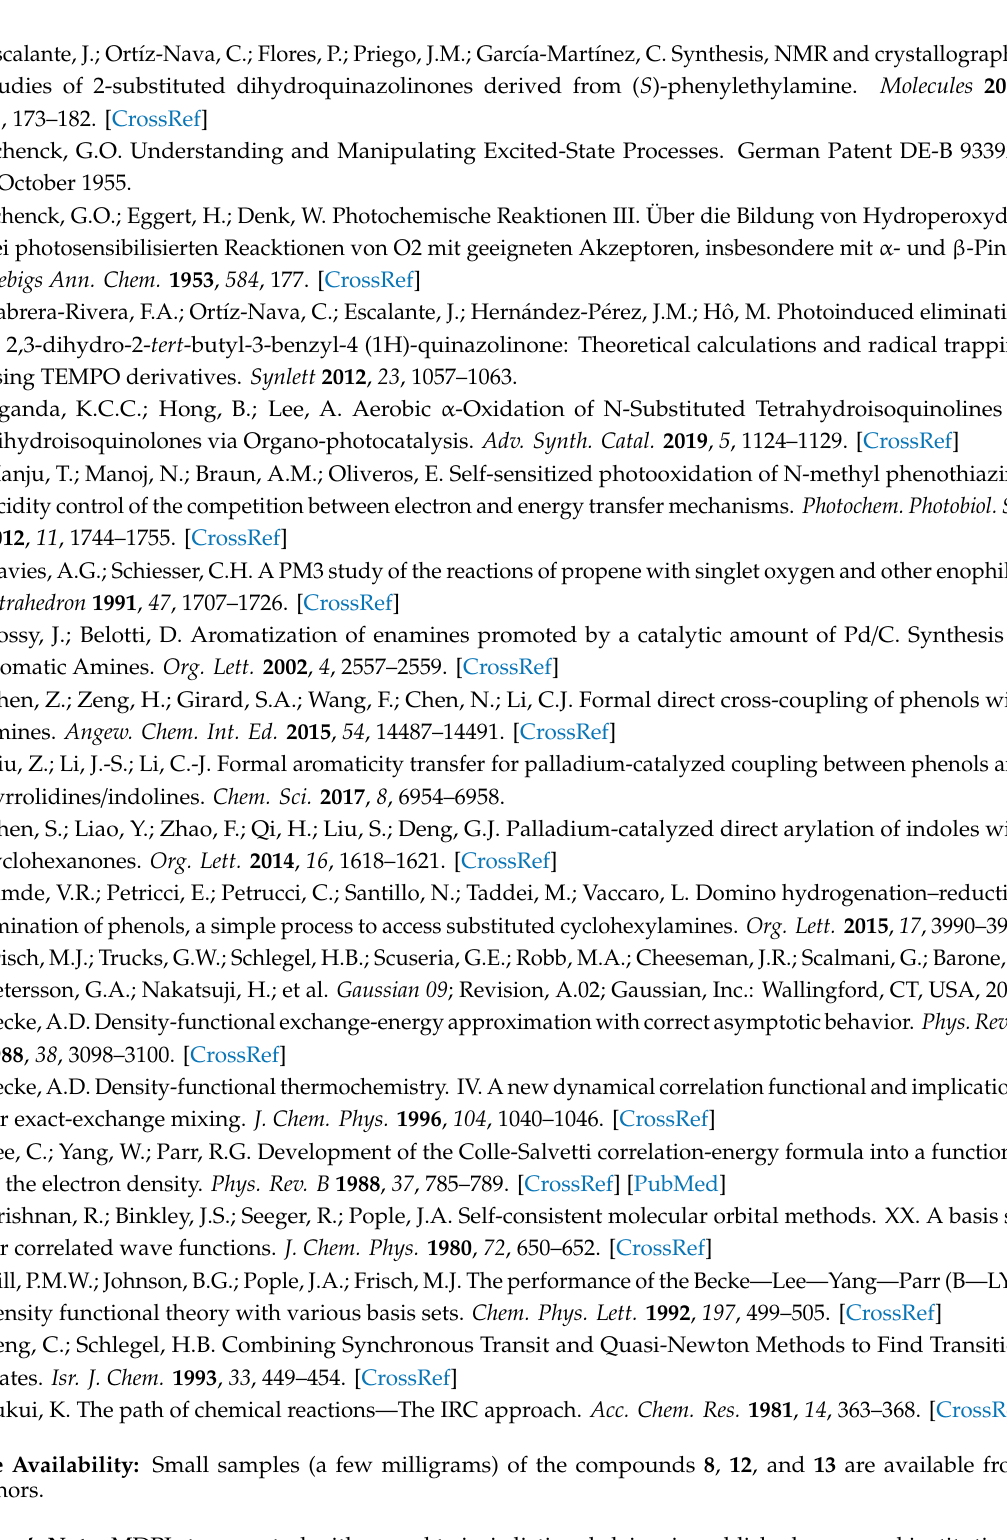
Sample Availability: Small samples (a few milligrams) of the compounds 8 , 12 , and 13 are available from the